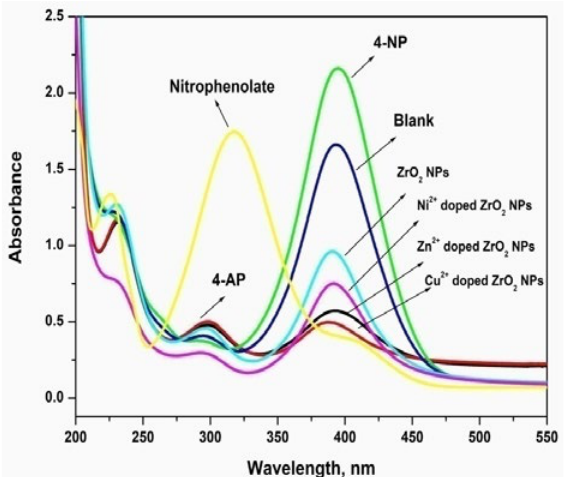
Fig. 7. The UV-Vis spectra of 4-NP reduction with undoped and doped ZrO Fig. 7 The UV-Vis spectra of 4-NP reduction with undoped and doped ZrO 2 NPs.